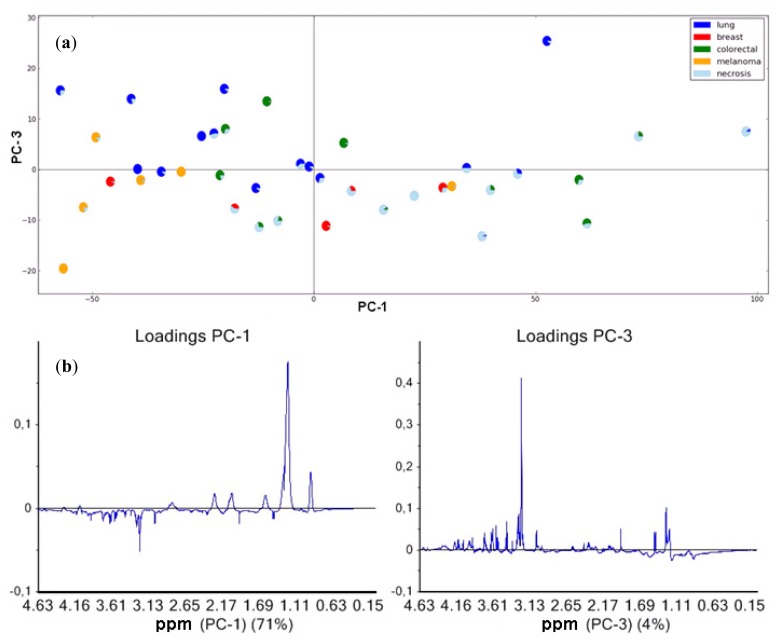
(a) Principal component analysis (PCA) score plot of PC-1 (explained variance 71%) and PC-3 (explained variance 4%) based on single-pulse spectra (n = 39) showing the distribution of the metastases from four different primary cancer diagnoses; lung (blue), breast (red), colorectal (green) and melanoma carcinomas (yellow). The light blue colored part of the circles reflects the content of necrotic tissue determined by HES staining post HR-MAS; (b) Loading plots for PC-1 and PC-3; Samples with high score values for PC-1 have higher lipid levels. High score values for PC-3 are mainly due to high levels of phosphocholine (PCho).